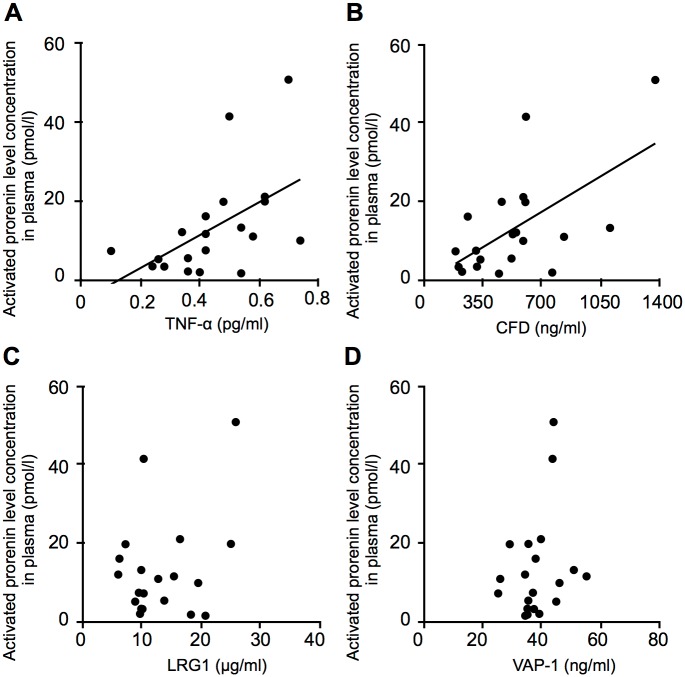
Correlations between activated prorenin and inflammatory mediators elevated in the plasma of PDR patients.Correlation between activated prorenin and inflammatory mediators TNF-α (A), CFD (B), LRG1 (C) and VAP-1 (D) in the plasma of patients with PDR (n = 20, Spearman rank correlation).